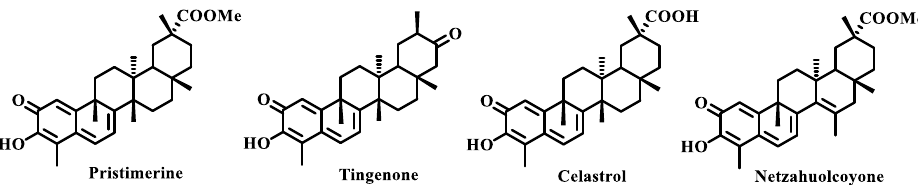
Figure 1. Most frequently reported antimicrobial celastroloids from Celastraceae species.